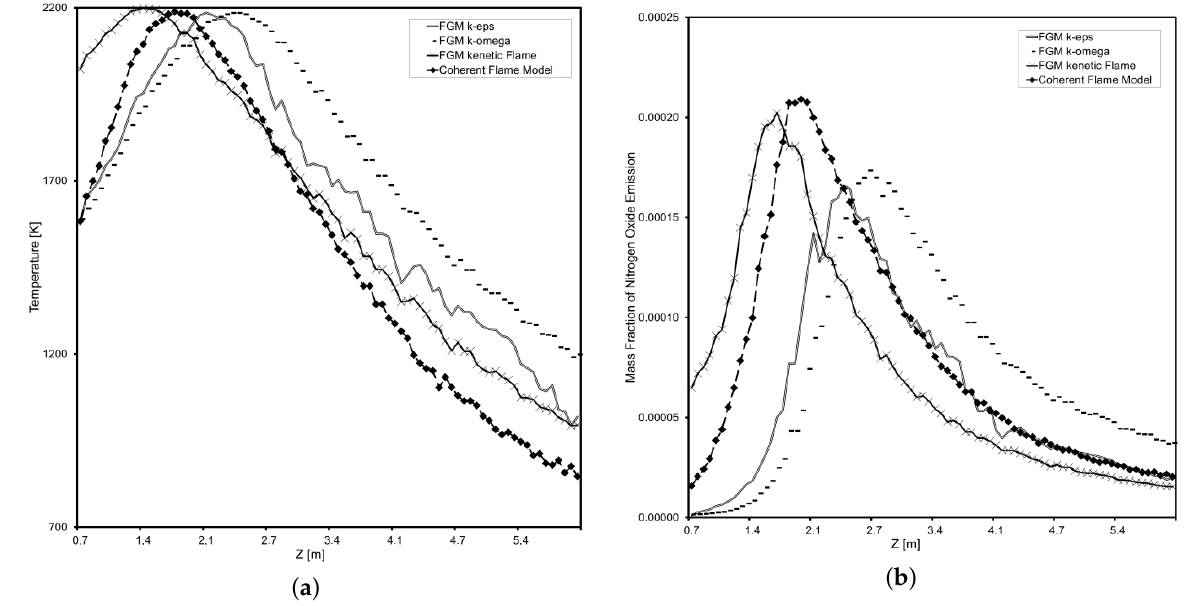
Figure 6. Comparison of test calculations of the methane–air mixture for different combustion models of the STAR-CCM+ multidisciplinary platform: ( a ) temperature comparison; ( b ) comparison of NO X